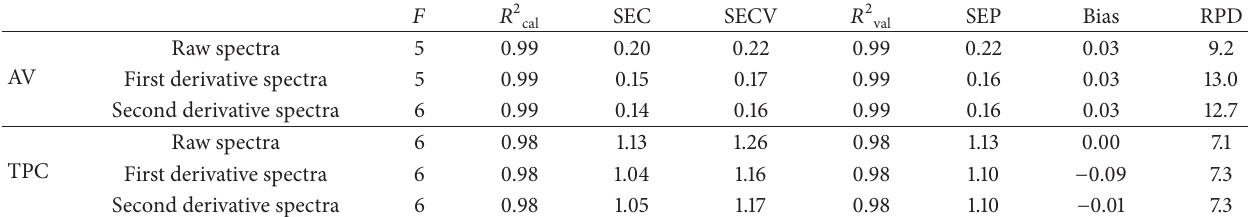
Table 2: PLS analysis results for predicting the AV and TPC values of frying oil samples.